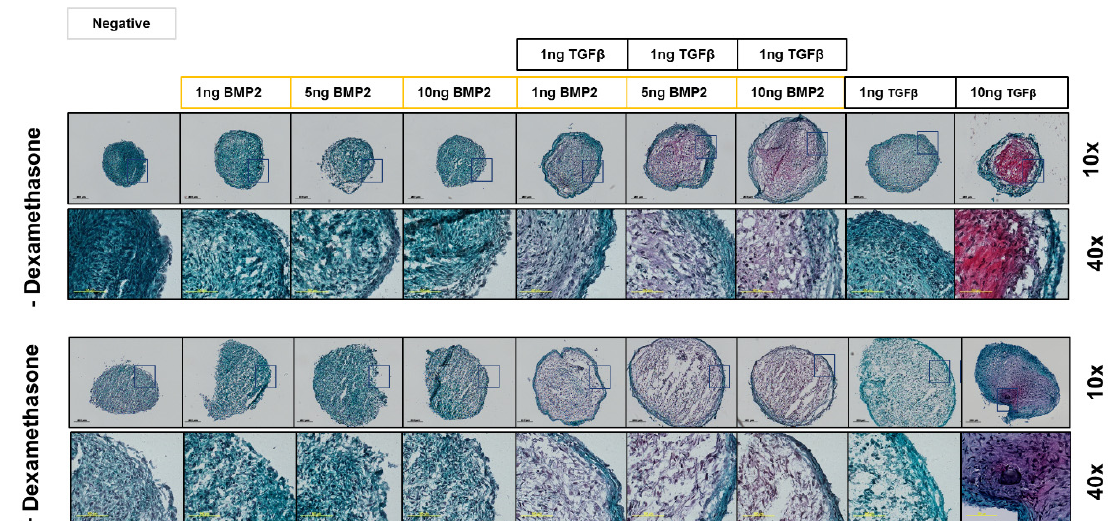
Figure 6. Safranin-O / Fast Green staining of hSDSC pellets exposed to TGF- β 1 and BMP-2 in the presence or absence of dexamethasone. hSDSCs in 3D culture were cultured for 21 days in the presence of 10 ng / mL TGF- β 1 (positive control) or in its absence (negative), low TGF- β 1 concentration (1 ng / mL TGF- β 1), various concentration of BMP-2 alone (1 ng / mL BMP-2, 5 ng / mL BMP-2, 10 ng / mL BMP-2) or BMP-2 in combination with 1 ng / mL TGF- β 1 (1 ng / mL TGF- β 1 + 1 ng / mL BMP-2, 1 ng / mL TGF- β 1 + 5 ng / mL BMP-2 and 1 ng / mL TGF- β 1 + 10 ng / mL BMP-2). The intensity of Safranin-O (Red) staining is directly proportional to the proteoglycan content inside the pellet, while green structures represent the counterstaining with Fast Green solution. The figures are representative of four separate experiments in four di ff erent donors. Black scale bar for 10 × objective = 200 µ m, yellow scale bars for 40 × objective = 1000 µ m.